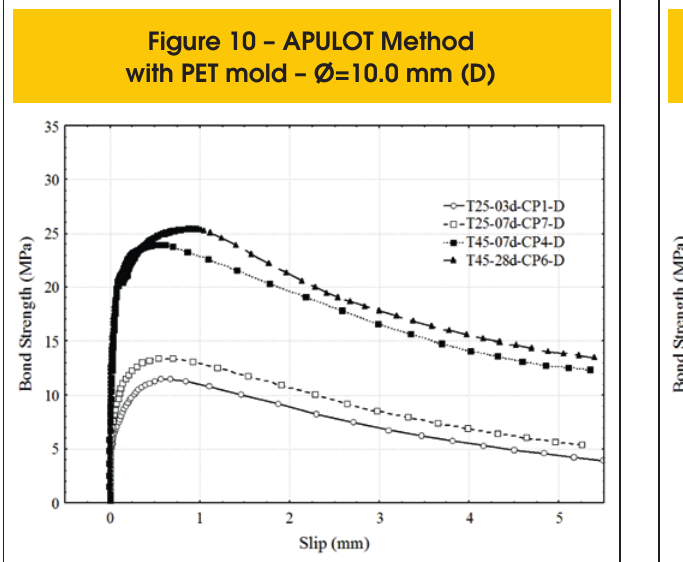
Figure 10 – APULOT Method with PET mold – Ø=10.0 mm (D)